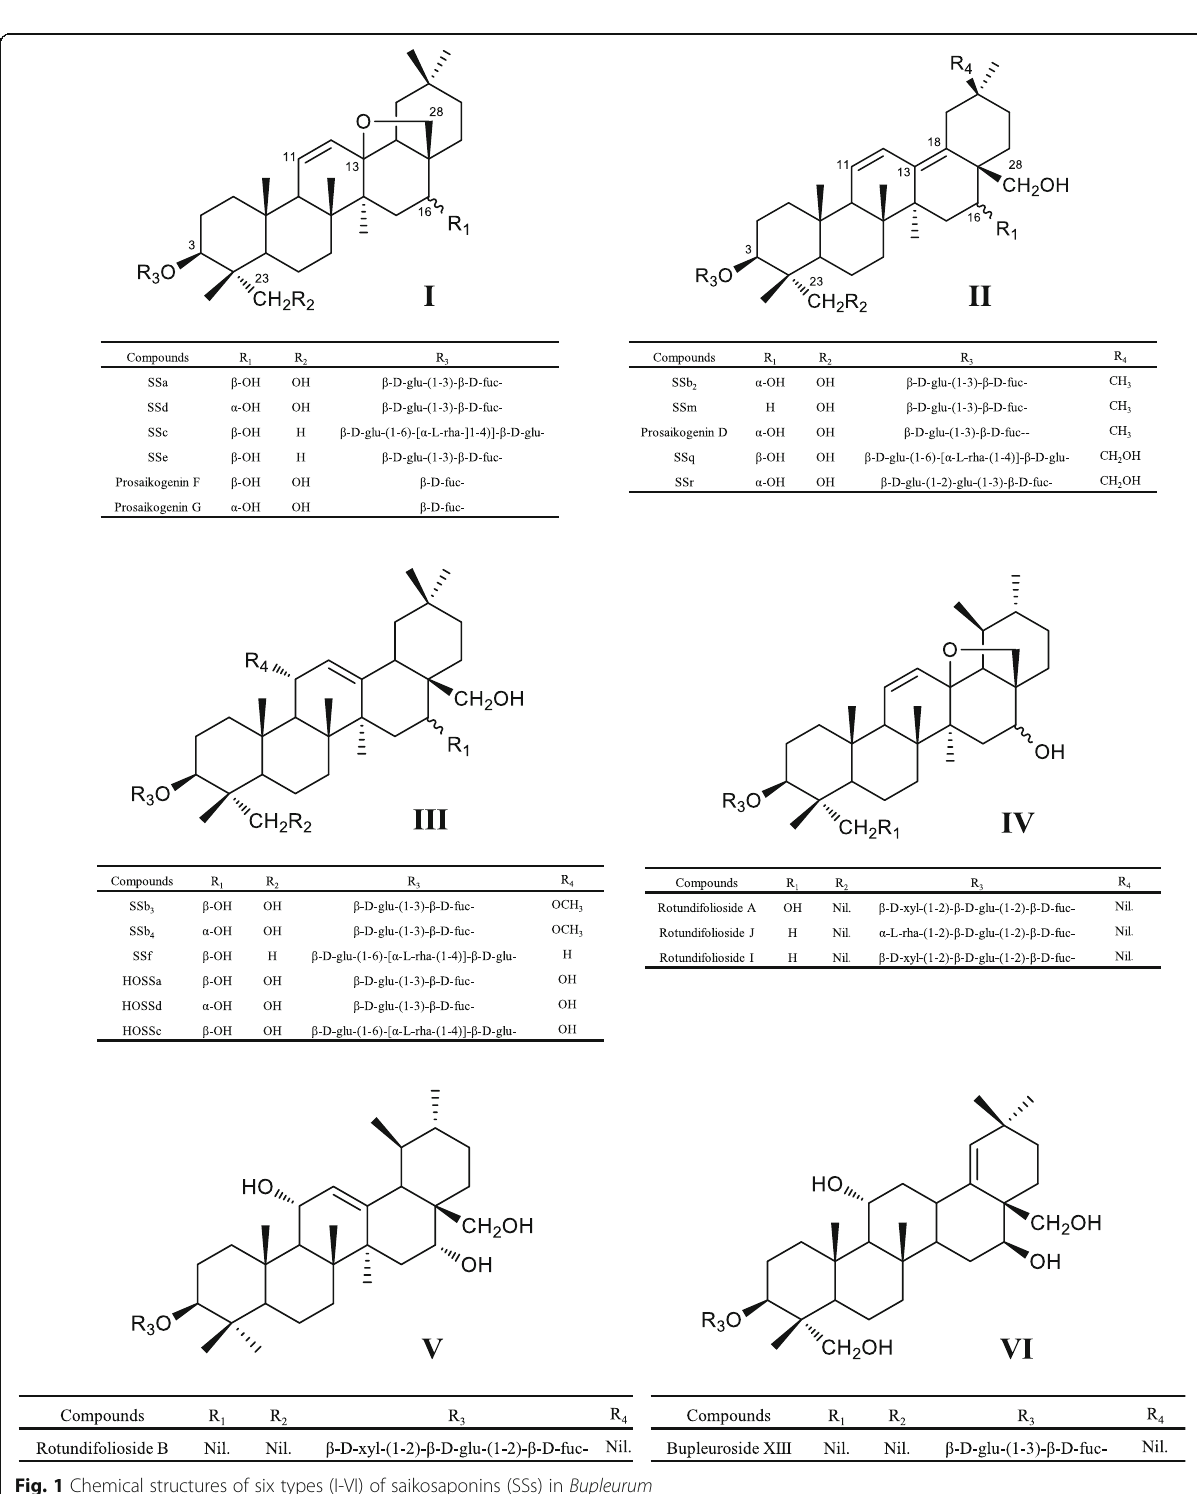
Fig. 1 Chemical structures of six types (I-VI) of saikosaponins (SSs) in